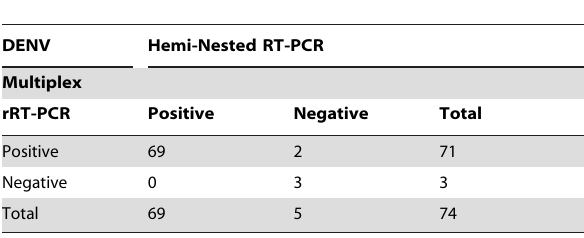
Table 5. Comparison of samples collected from patients in Nicaragua presenting within the first five days of a dengue- like